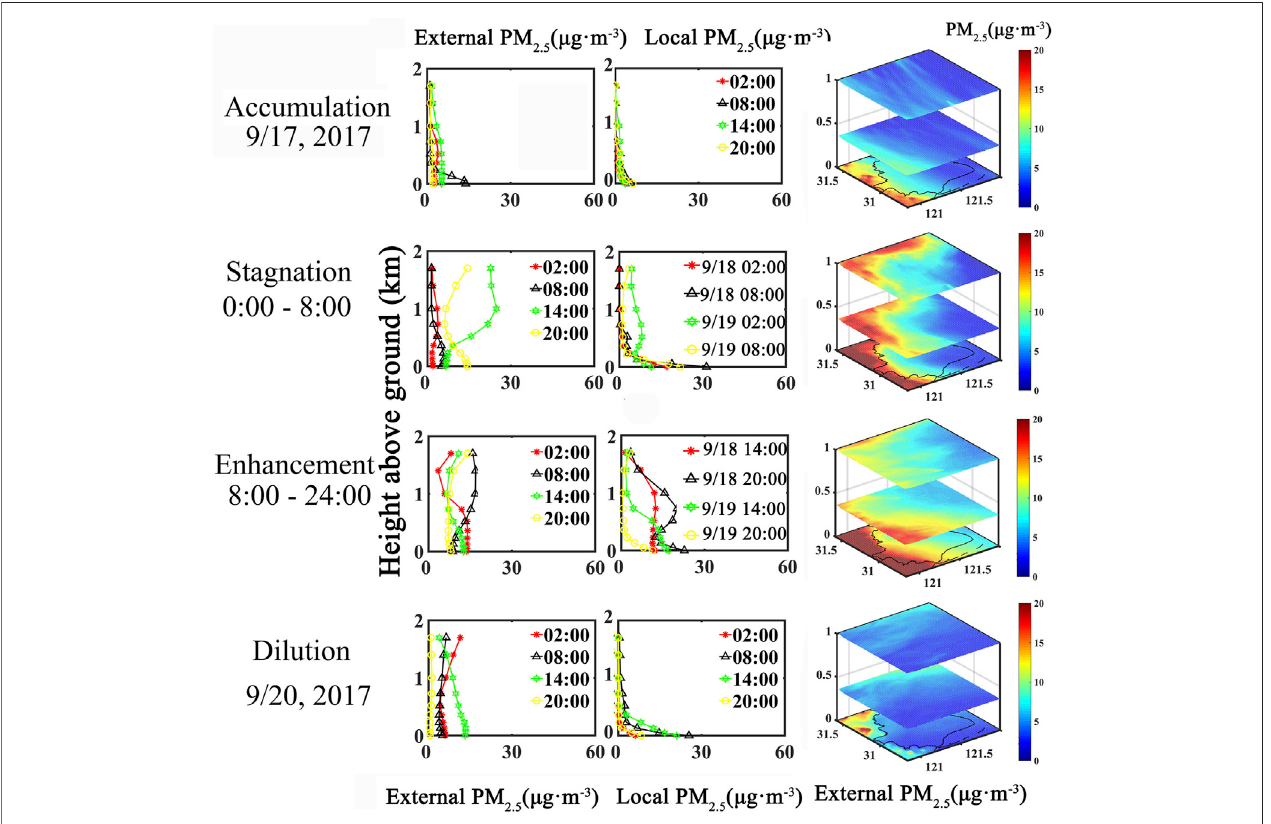
FIGURE 8 | Simulated local and external PM2.5 vertical pro fi les and vertical spatial distribution in four different stages in September 17 – 20, 2017.